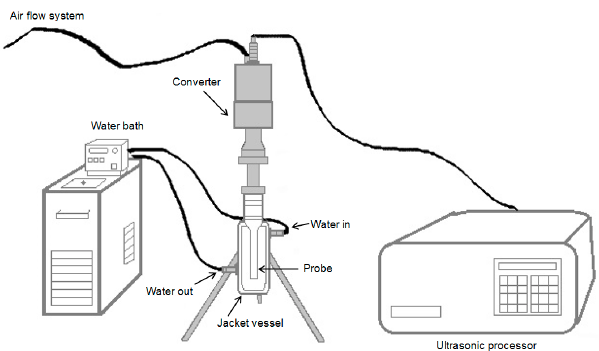
Figure 6. Ultrasonic equipment as a closed system used for ultrasonic extraction.